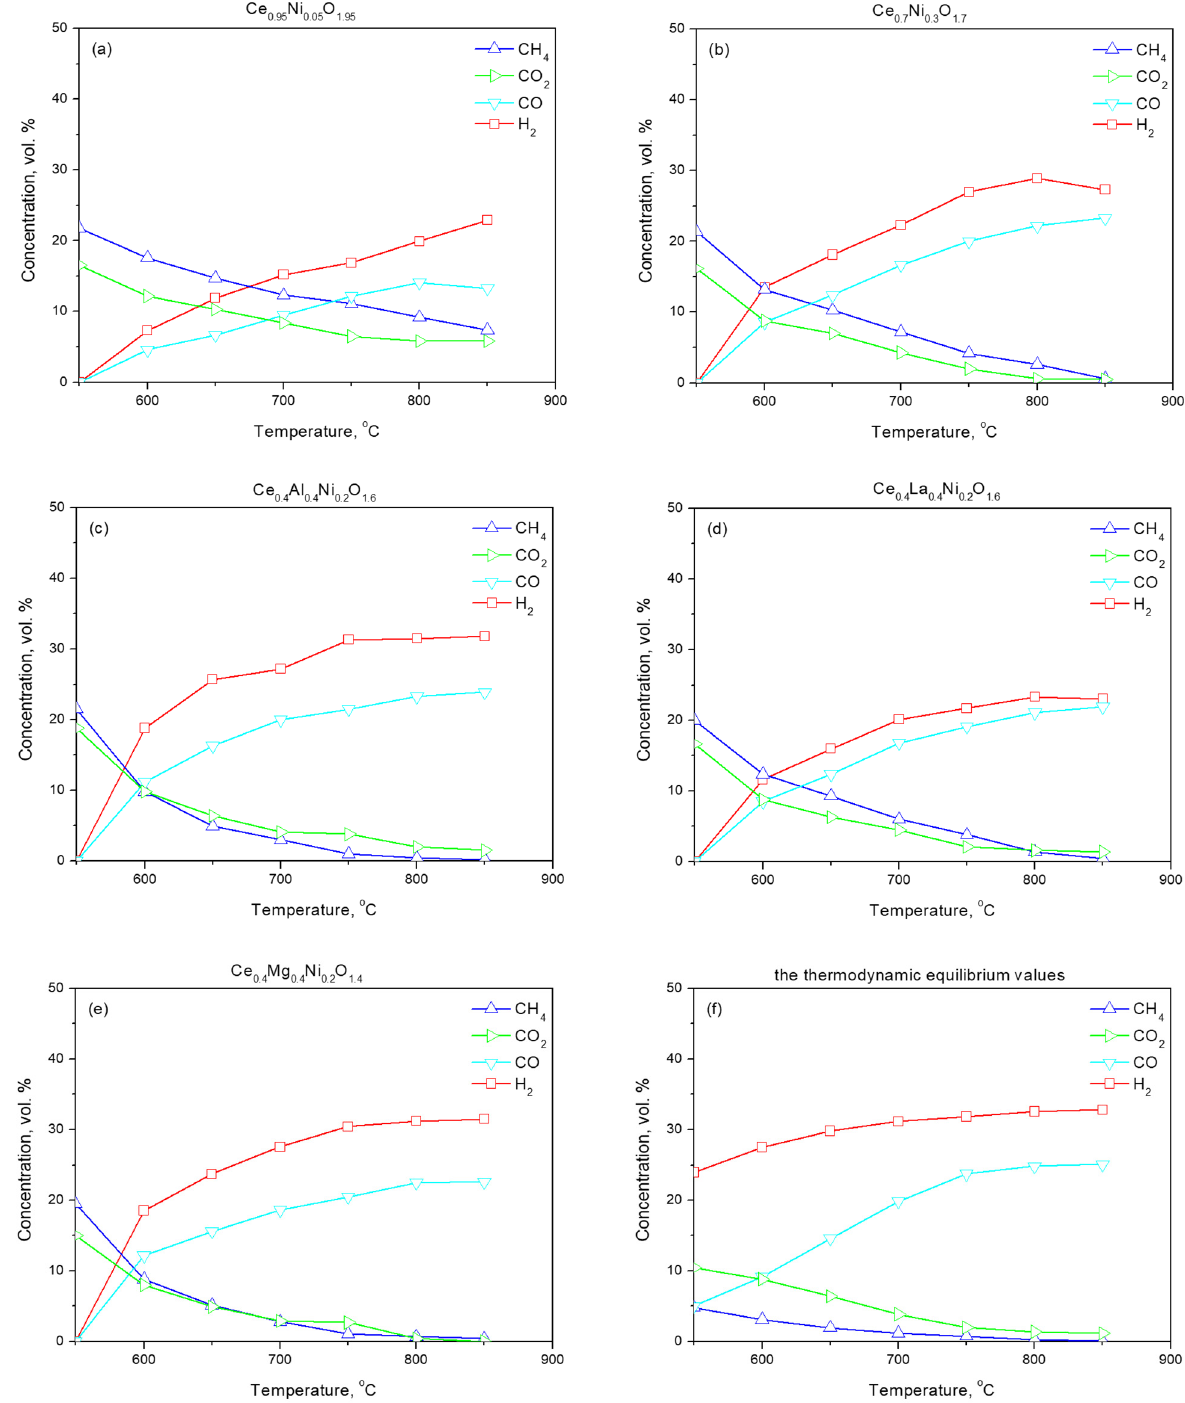
Figure 17. Temperature dependence of reagent and product concentrations during the bi-reforming of methane over Ce 1 − x Ni x O y ( a , b ) and (CeM) 0.8 Ni 0.2 O y ( c – e ) samples and the thermodynamic equilibrium values ( f ). ( a ) x = 0.05; ( b ) x = 0.3; ( c – e ) M/Ce molar ratio is equal to 1, M = Al ( c ), La ( d ), and Mg ( e ).